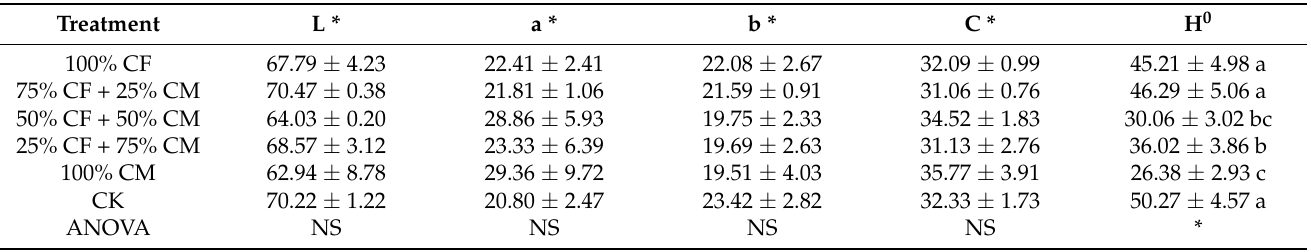
Table 4. Effect of different ratios of cow manure and chemical fertilizers on the colour of the shade side of